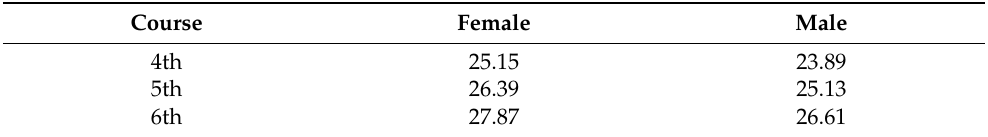
Table 2. Middle upper arm circumference cut-off values for schoolchildren with obesity per course and sex.